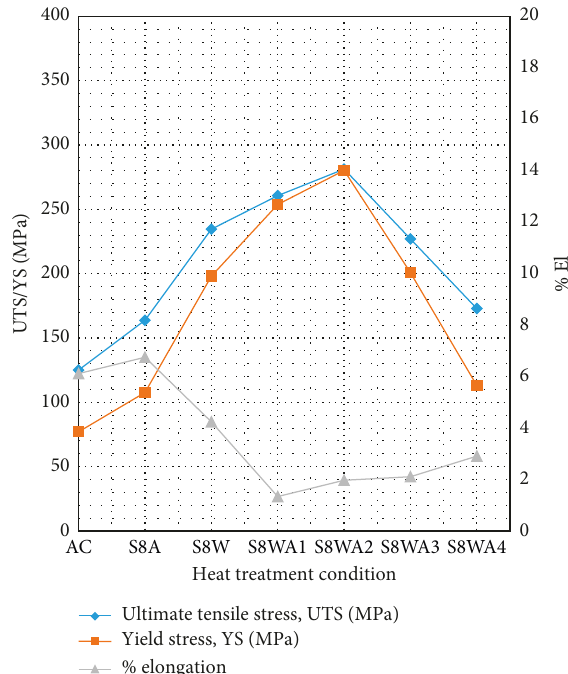
Figure 6: Average values of UTS, YS, and %El obtained at 250 ° C, for alloy A in the as-cast condition, and after heat treatments comprising SHT for 8h.